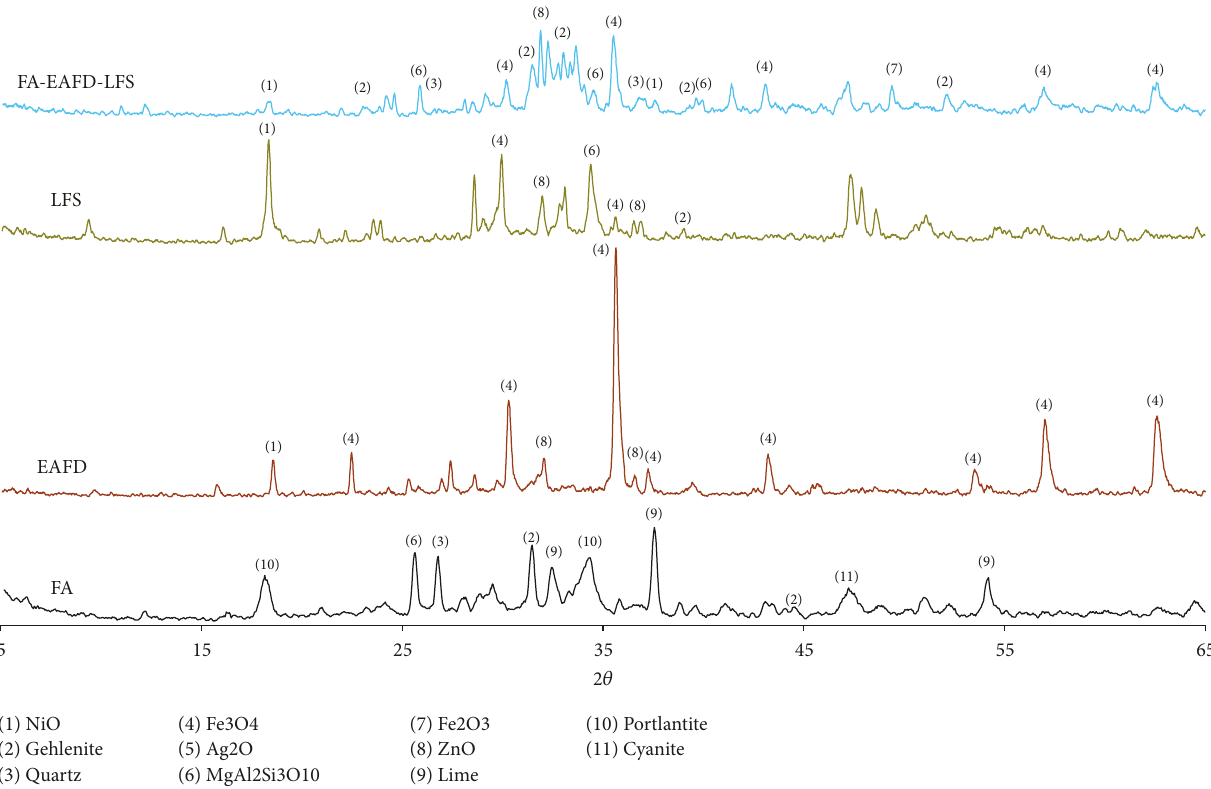
Figure 2: XRD patterns of the sintered samples containing only FA, EAFD, LFS, and their ternary mixture. The numbered peaks correspond to the identified phases, shown in the legend (below the figure).